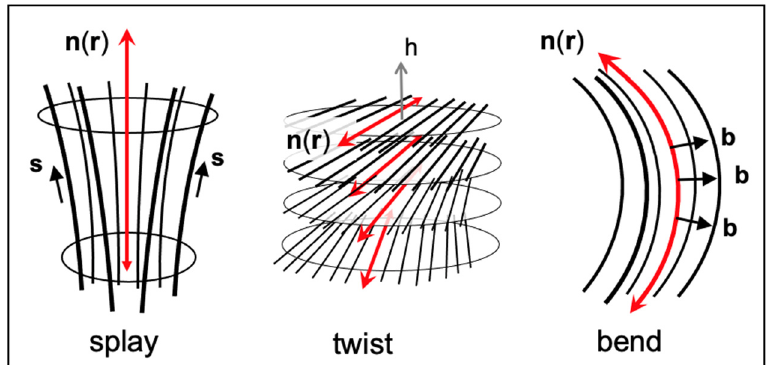
Figure 1. Three canonical bulk deformations of the nematic director field. In the Frank–Oseen continuum description, these deformations span macroscopic length scales. Splay ( s ) and bend ( b ) vectors are shown respectively, tangentially and radially with respect to the director field lines. The director field n ( r ) rotates about h in the twist distortion; double headed red arrows emphasize the apolarity of the nematic director n .